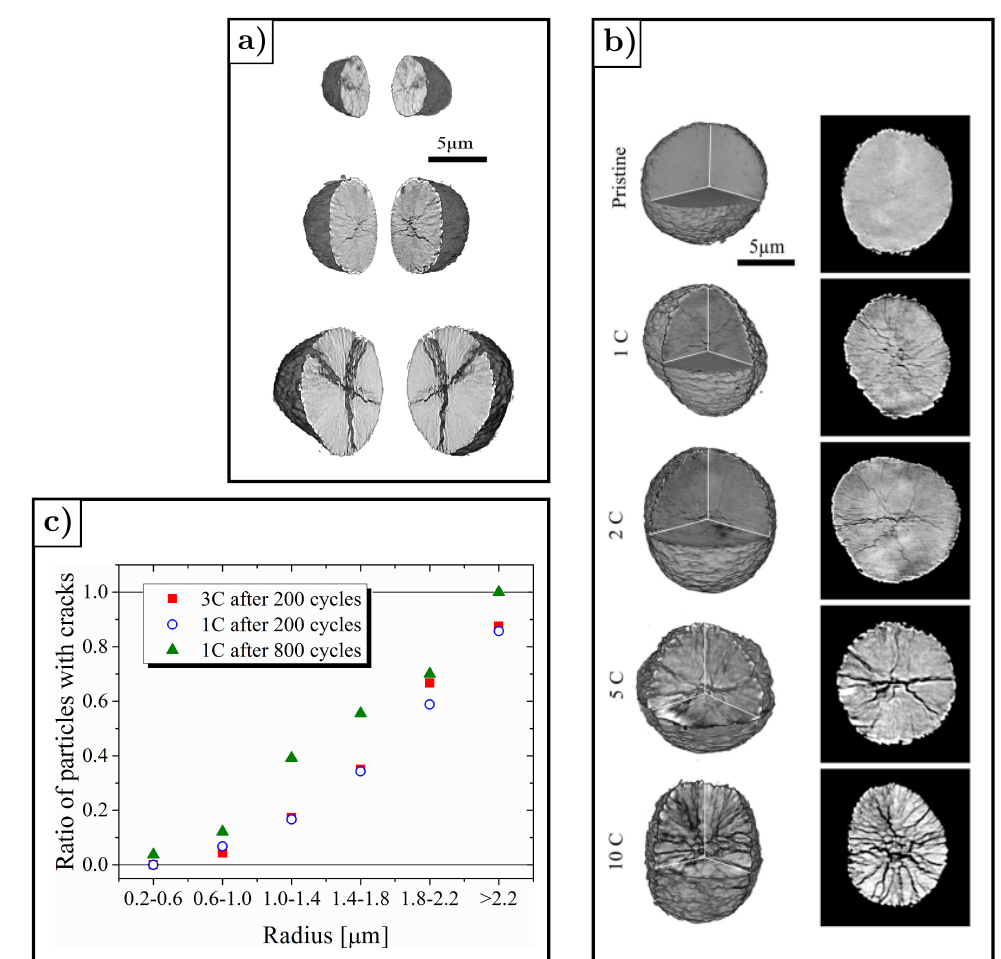
Figure 34. ( a ) Fracture in NMC particles of different size, after 50 cycles at 10C. ( b ) Fracture in NMC particles after 50 cycles at 1C, 2C, 3C, 5C and 10C. Reprinted with permission by Elsevier from [116], Copyright 2018. ( c ) Fracture occurrence in LiMn 1.95 Al 0.05 O 4 as a function of current rates and particles radius. Reprinted with permission by Elsevier from [155], Copyright